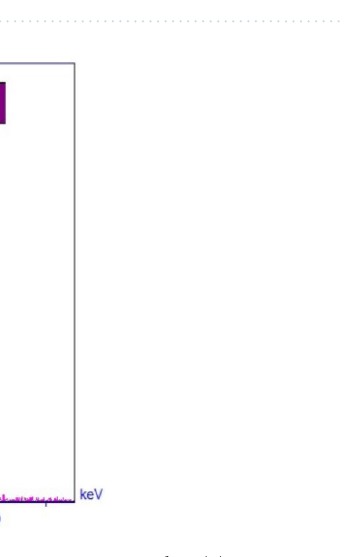
Figure 4. The EDX spectrum of the Iron oxide@PMO-ICS-Pr-SO 3 H mesoporous catalyst ( 1